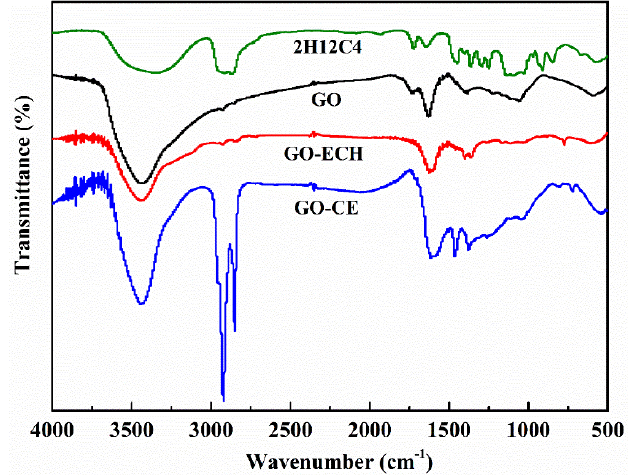
Figure 3. The FTIR of GO-CE, GO-ECH, GO, and